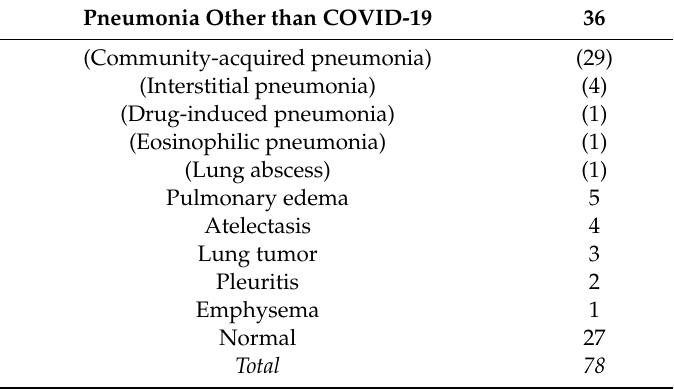
Table 3. List of diagnoses in COVID-19-negative patients.